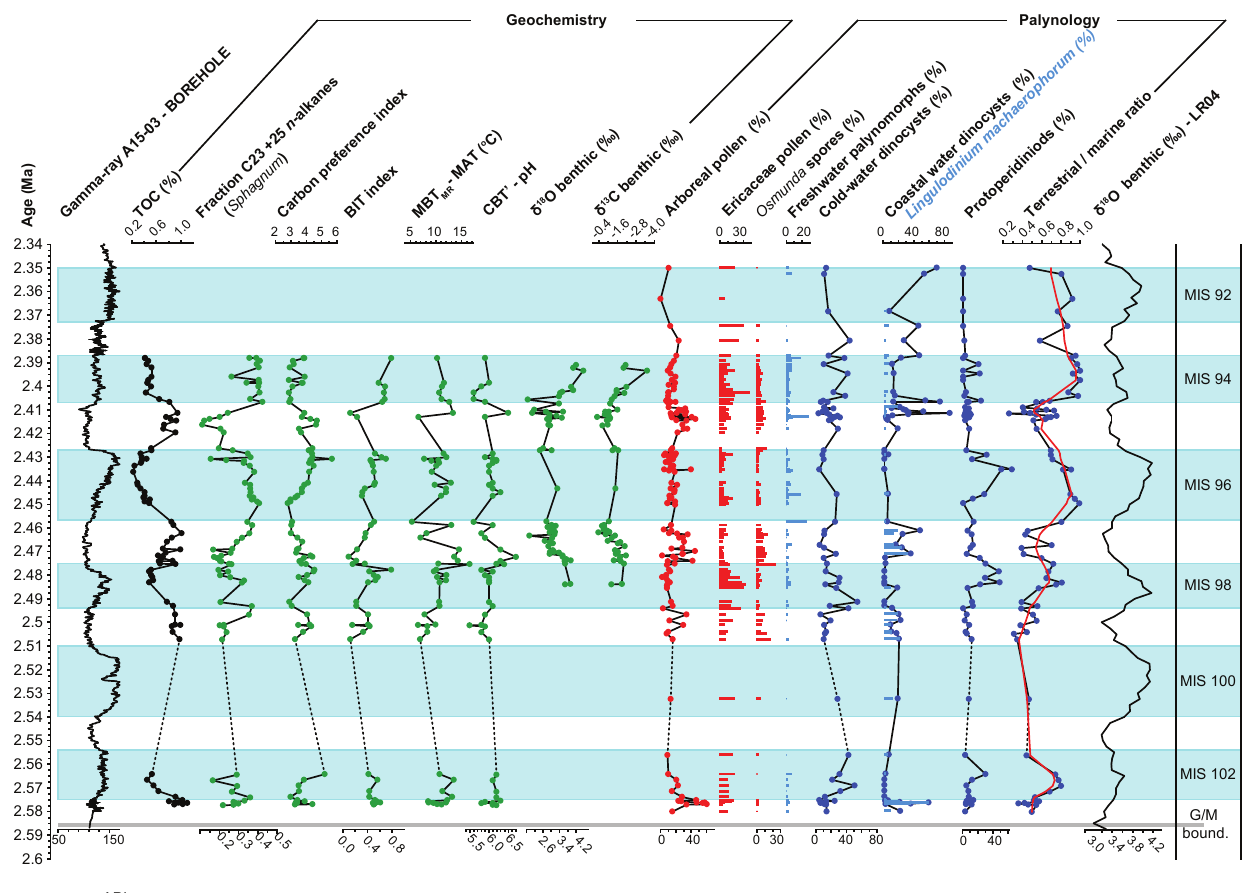
Figure 3. Spliced record of A15-3 and A15-4 showing the principal geochemical and palynological indices. Shaded blue intervals represent the identified glacial MIS delimited by the gamma-ray transitions following Kuhlmann et al. (2006a, b). Data density is dependent on type of sample as indicated in Fig. 1. Age scale is based on correlation and LOESS interpolation of the identified MIS transitions to the LR04 benthic stack (Lisiecki and Raymo, 2005) as shown in Fig S3. Data are available in Tables S2 and S3. Red line in the T / M ratio is a LOWESS (locally weighted scatter plot smoothing) function with span